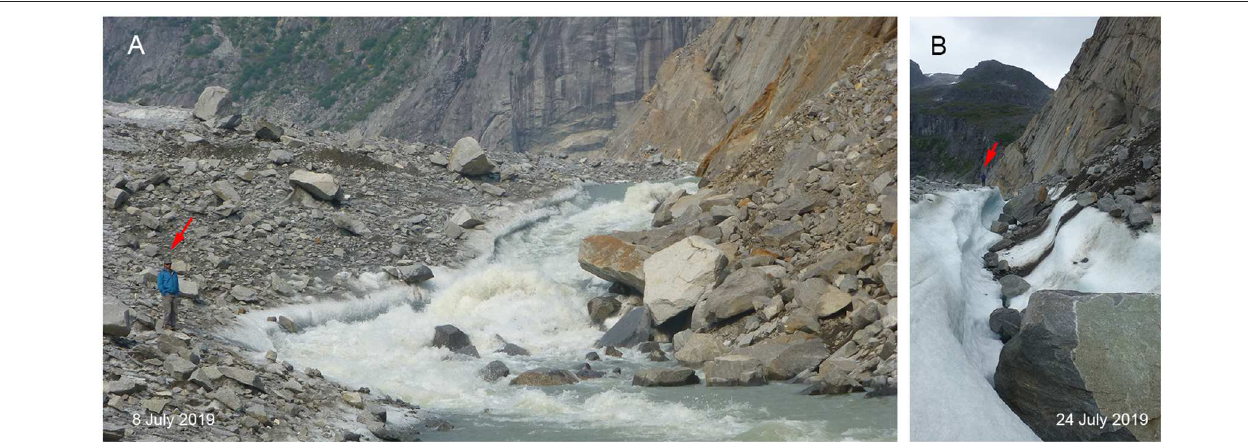
FIGURE 13 | (A) Spillway during the second day of overflow on 8 July 2019. (B) Remnant spillway after 6 days of overflow. Note the person for scale (red arrow). Erosion reached up to 4 m in the imaged portion of the channel. The photo was taken on 24 July 2019, ∼ 12 days after overflow ceased. Boulders and rocks partly filling in the channel originated from the ice-cored